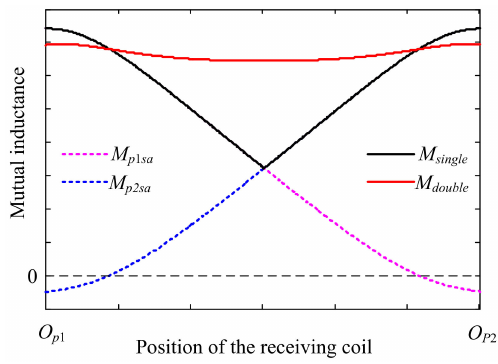
Figure 6. The comparative characteristics of the equivalent total mutual